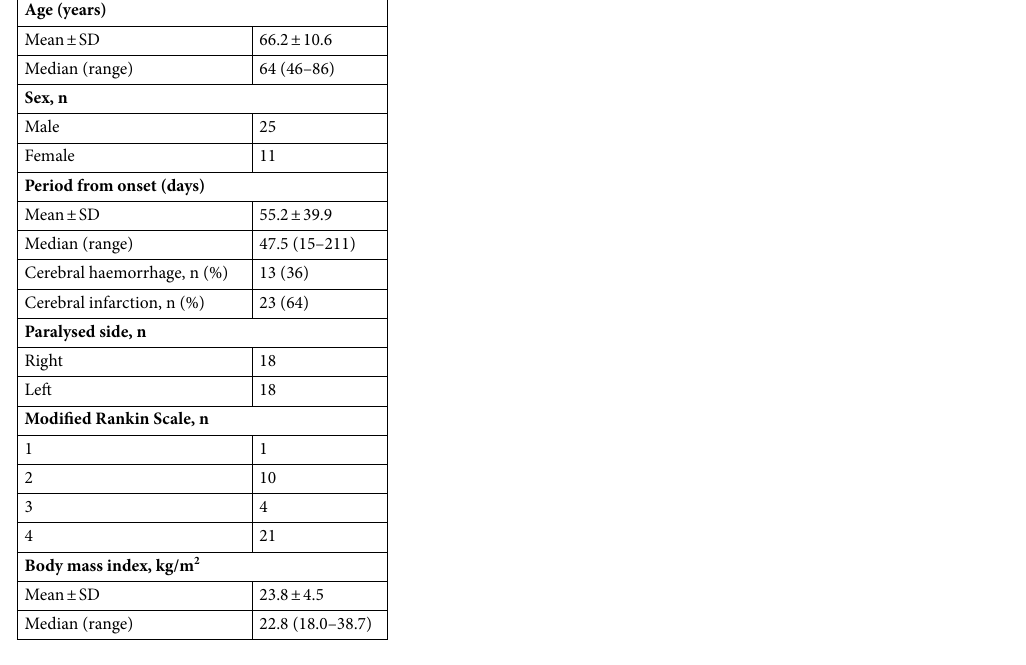
Table 1. Patient characteristics (n =